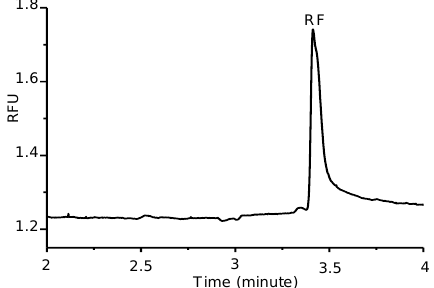
Figure 2. Electropherogram of 1/2 diluted sage herbal tea (S3).Conditions; 50 µm × 50 cm capillary, 50 mbar 6s injection, 25 kV running voltage, 30 mM phosphate buffer at pH:9.9.